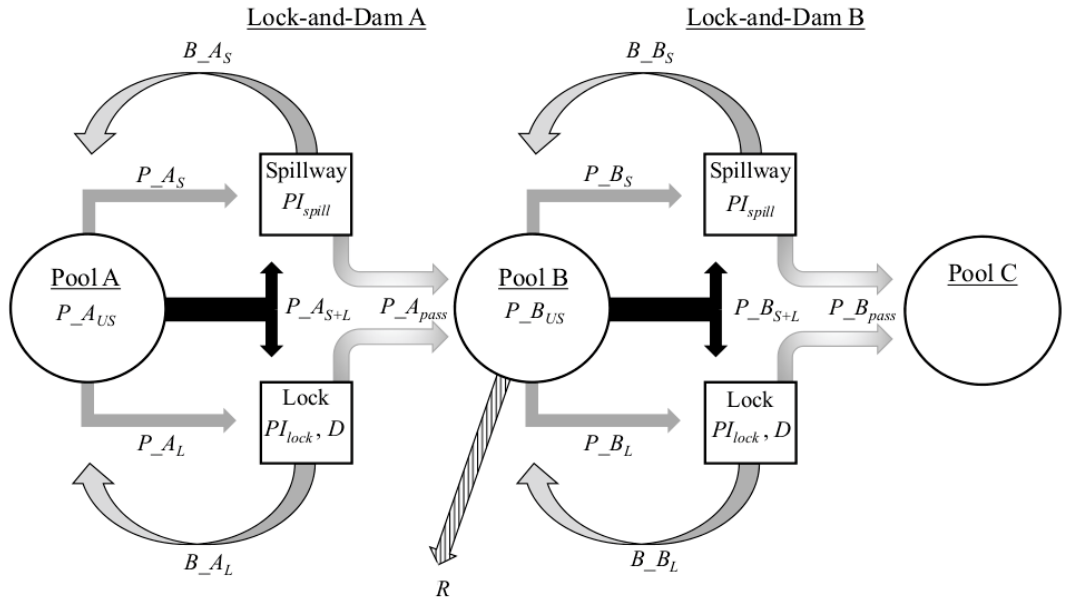
Figure 2. Schematic representation of the stochastic size-structured fish passage model (S-FPM). The model uses a silver carp population with five size classes that are released in Pool A